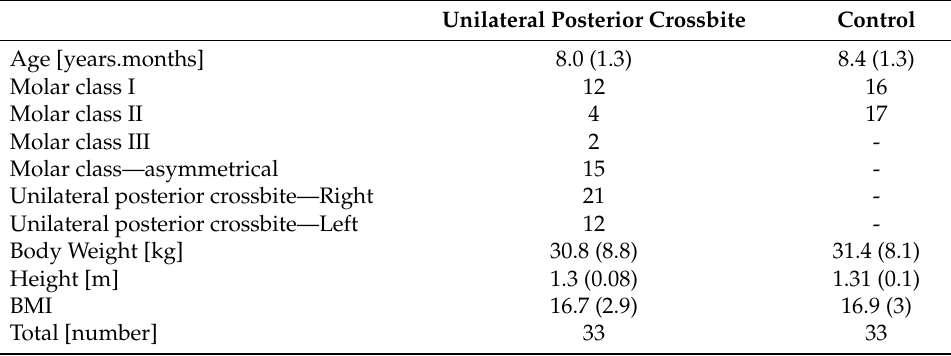
Table 1. Characteristics of included